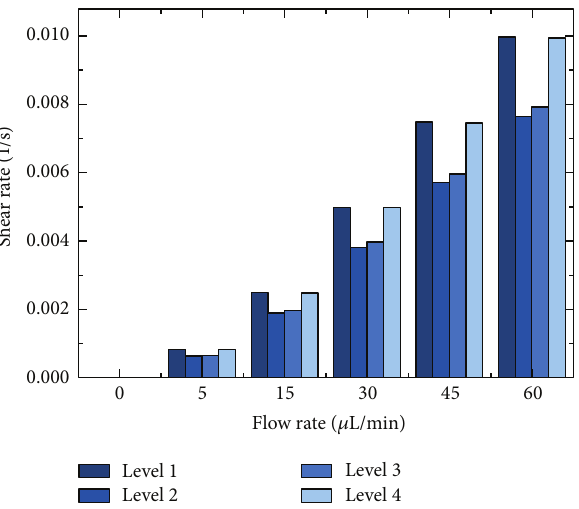
Figure 9: Shear rate for the analysis levels 1–4 at different nutrient supply